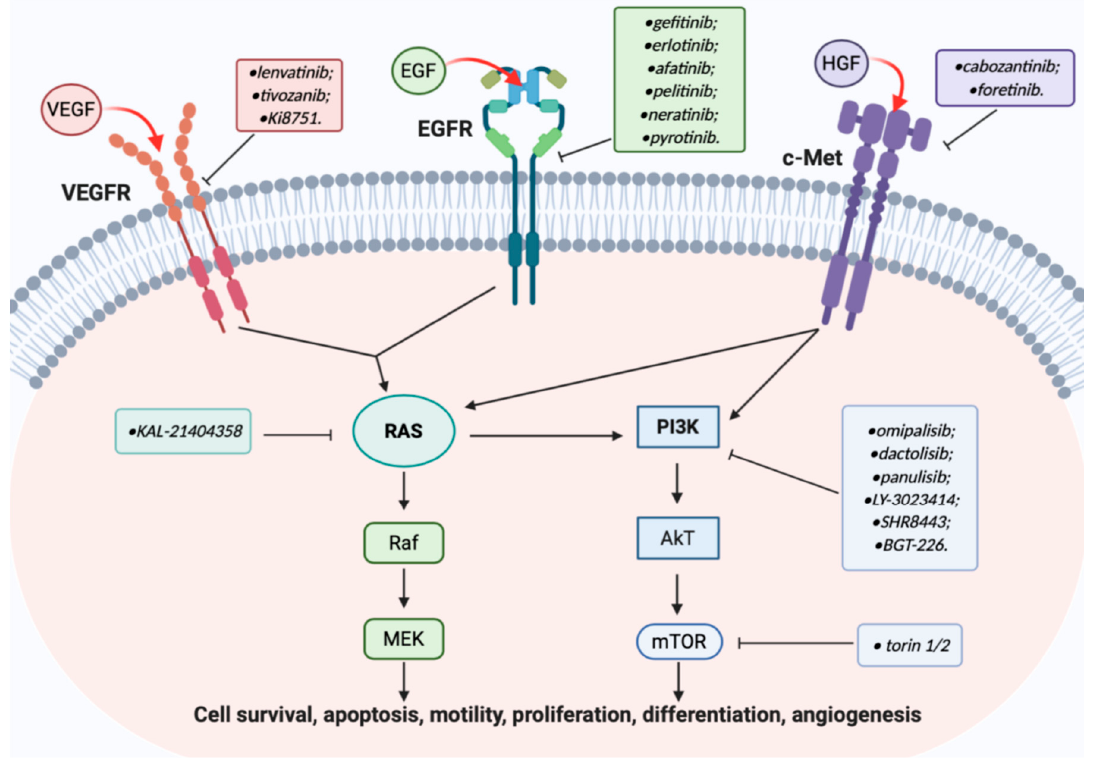
Figure 2. Cross-talk between EGFR, VEGFR, and c-Met signalling pathways; in boxes are reported some quinoline based inhibitors developed up to